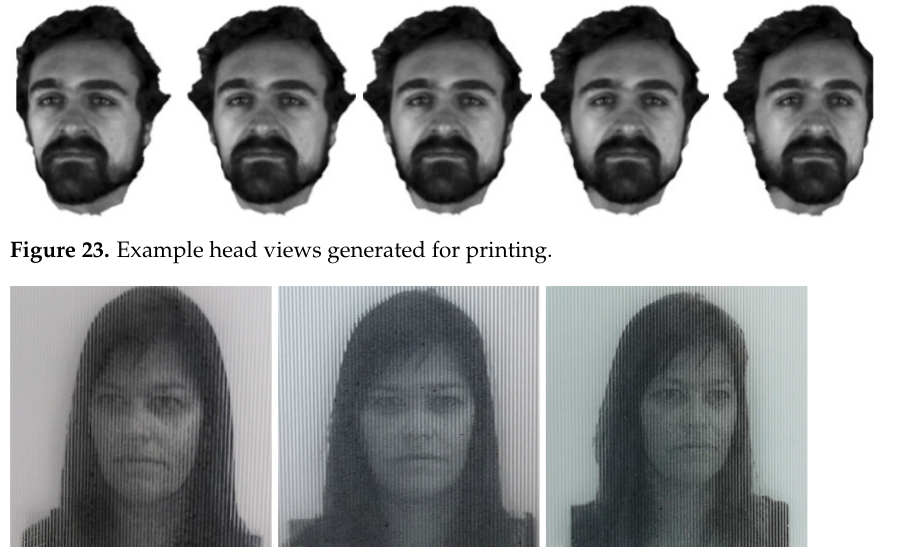
Figure 24. Imprinted lenticular card prototype—these images show the same card viewed from different perspectives.